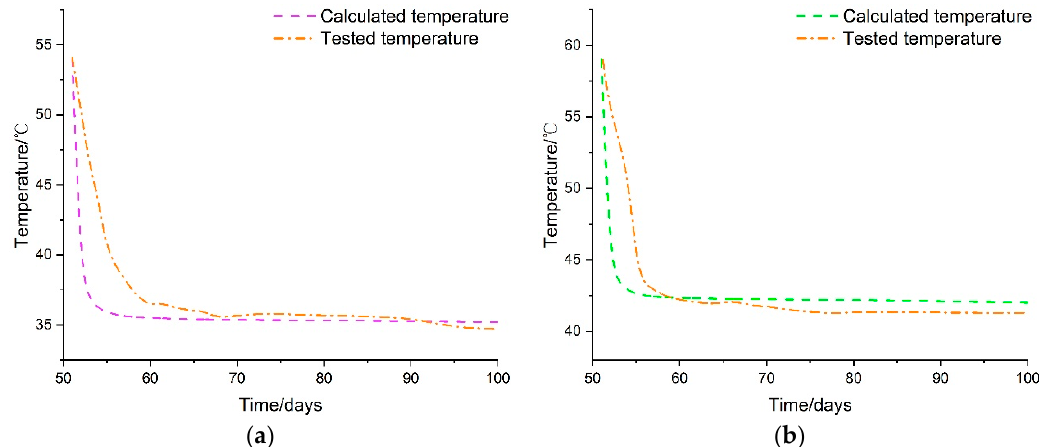
Figure 11. Comparison of the secondary lining temperature measured value and predicted value: (a) Test Location 1 and (b) Test Location 2.